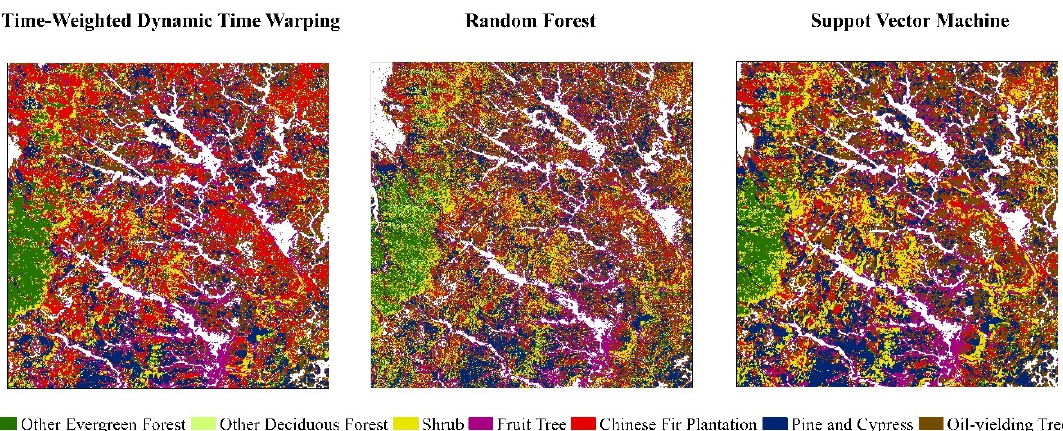
Figure 8. Comparison of forest-type maps in detail acquired by TWDTW, RF, and SVM.